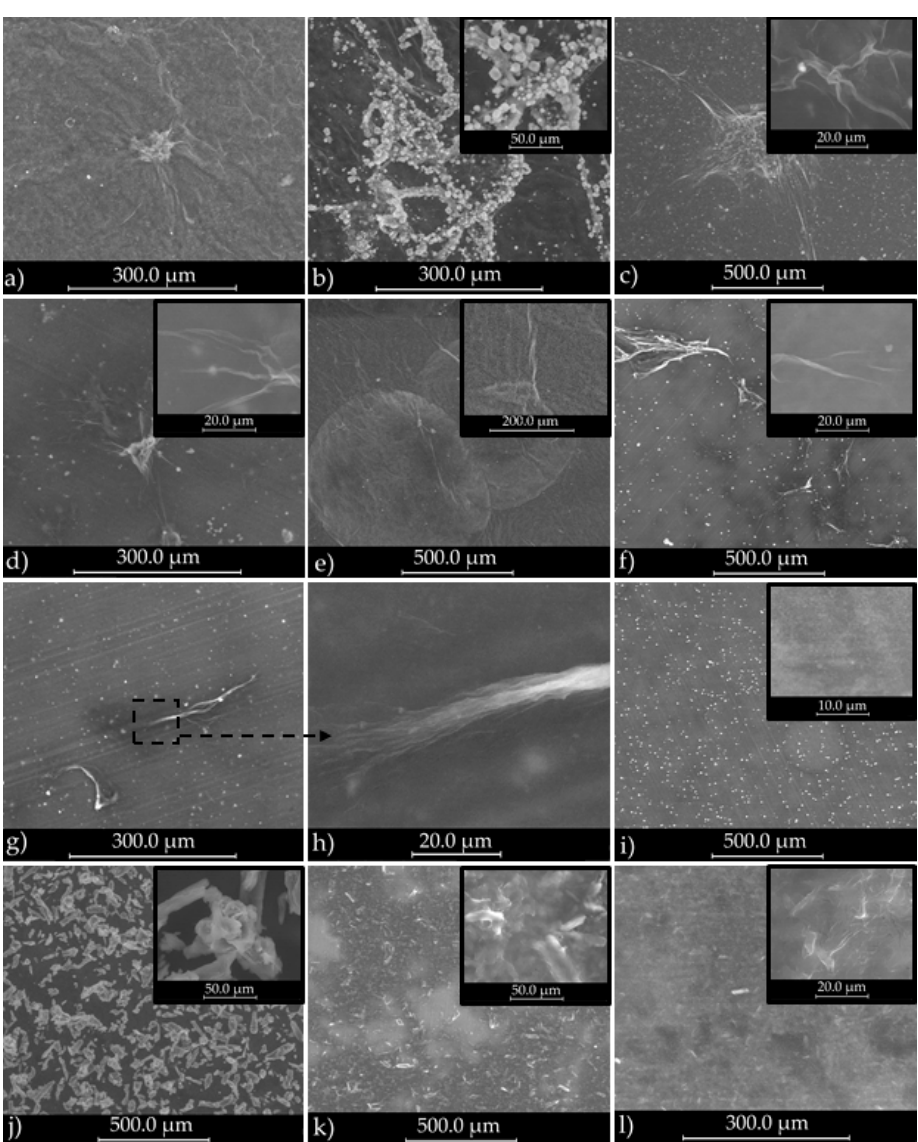
Figure 2. SEM images of biocellulose from Kombucha: ( a ) K_0 = initial membrane; ( b ) K_1M = K_0 washed with 1M NaOH; ( c ) K_B = K_4M after grinding with a blender; ( d ) K_CM = K_B after grinding with a colloidal mill; ( e ) K_AT = K_CM after atomization; ( f ) K_M1P = K_CM after 1 pass through microfluidizer; ( g ) K_M10P = K_CM after 10 passes through microfluidizer; ( h ) K_M10P—disruption of a microfibril into nanofibrils after 10 passes; ( i ) K_M25P = K_CM after 25 passes through microfluidizer; ( j ) MC_0 = vegetal micro-crystalline cellulose; ( k ) MC_1P = MC_0 after 1 pass; ( l ) MC_25P = MC_0 after 25 passes through microfluidizer.